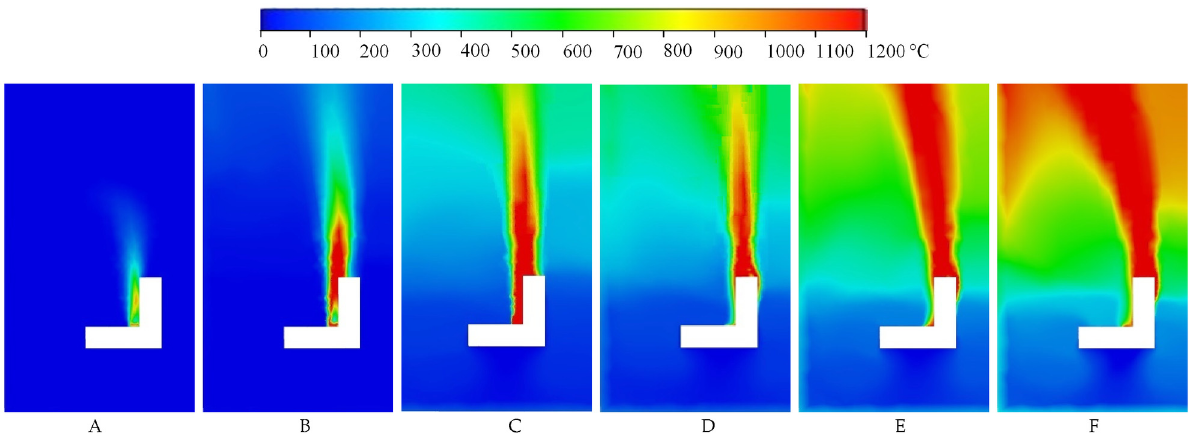
Figure 15. Temperature distributions at the sofa symmetry plain at selected moments (description in text).